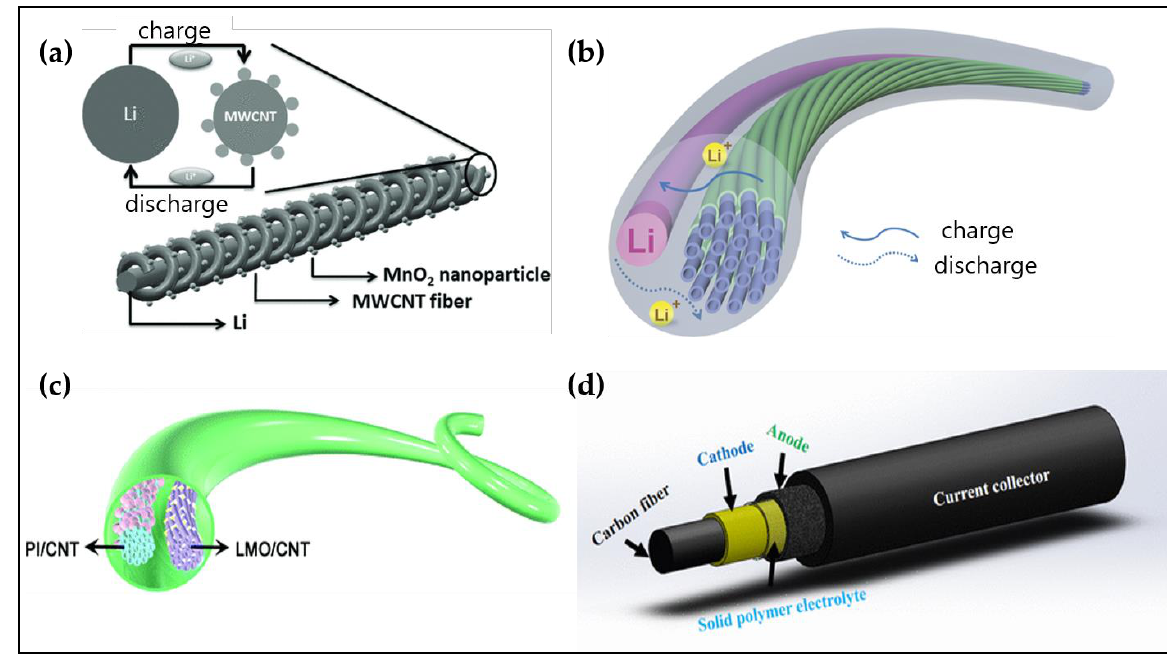
Figure 6. Schematic illustration of representative fiber-based lithium-ion batteries. ( a ) MWCNT-based battery fiber. Reproduced with permission from [139], Copyright (2013), Wiley. ( b ) Si-based battery fiber. Reproduced with permission from [48], Copyright (2014), Wiley. ( c ) Aqueous lithium-ion battery fiber. Reproduced with permission from [140], Copyright (2016), Royal Society of Chemistry. ( d ) All-solid-state battery fiber. Reproduced with permission from [141], Copyright (2019), American Chemical Society.